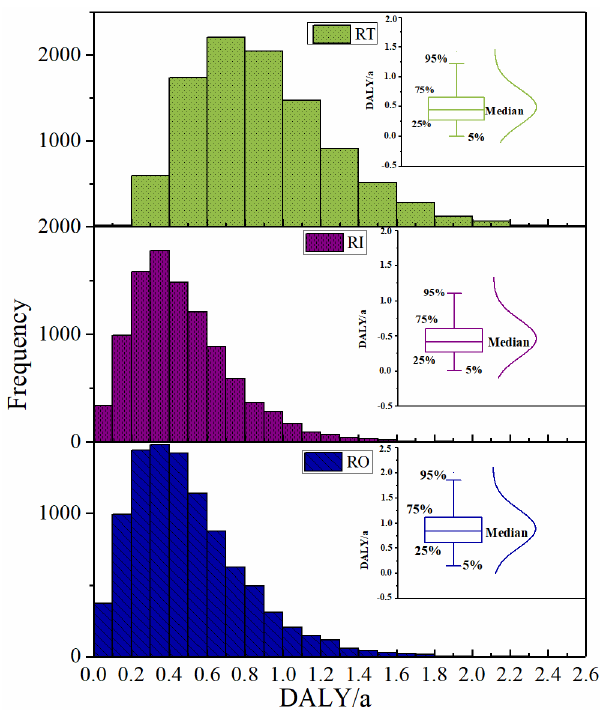
Figure 8. Rice simulation results of the DALY